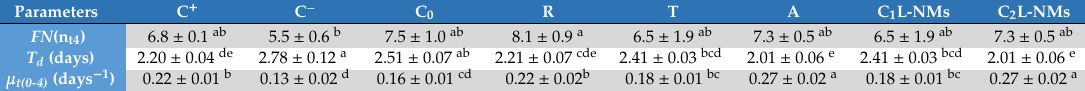
Table 2. Growth parameters of Lemna minor L. measured after treatments for 96 h (4 days) with di ff erent nutrient solutions and nanofibrous products (NMs): FN = frond number; T d = doubling time of the FN ; µ t(0-4) = average specific growth rate; C + = fully Fe-supplied duckweed plants; C − = totally Fe-deprived duckweed plants; C 0 = duckweeds grown in Fe-limiting conditions; R = L. minor plants resupplied with soluble Fe after an Fe-free pre-treatment; T = plants grown as C − and also incubated with NMs (catechol-free); A = duckweeds grown as C + and also incubated with NMs (catechol-free); C 1 L-NMs = plants as in C 0 and also incubated with NMs loading catechol at a low concentration (C 1 = 5 mM catechol); C 2 L-NMs = plants as in C 0 and also incubated with NMs loading catechol at a high concentration (C 2 = 100 mM catechol) (check the text for more details). Data are the mean values of six replicates ± standard error (SE). One-way ANOVA was applied, and data followed by di ff erent letters in the same row are significantly di ff erent (LSD test, p < 0.05). Parameters C + C